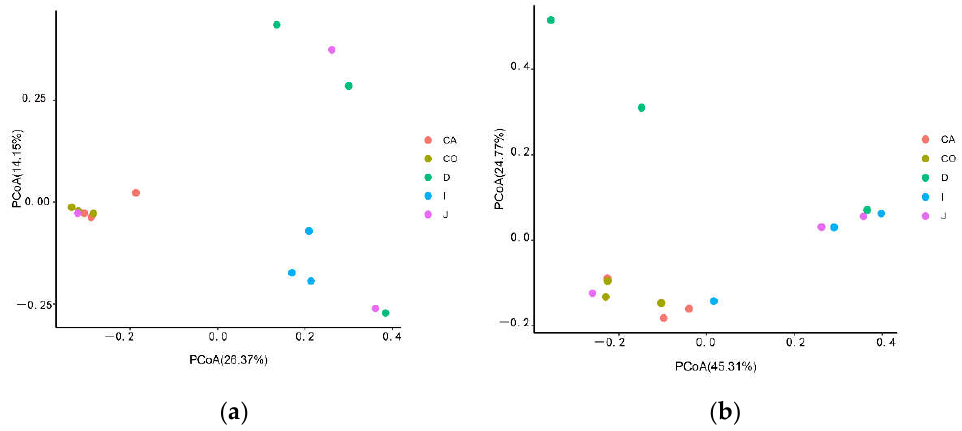
Figure 3. PCoA derived UniFarc distance map. ( a ) Shows the unweighted UniFrac distance. ( b ) Shows the weighted UniFrac distance. Each sample is represented by a point on the map. The difference in gut microbiota between samples is expressed as the distance between two points.